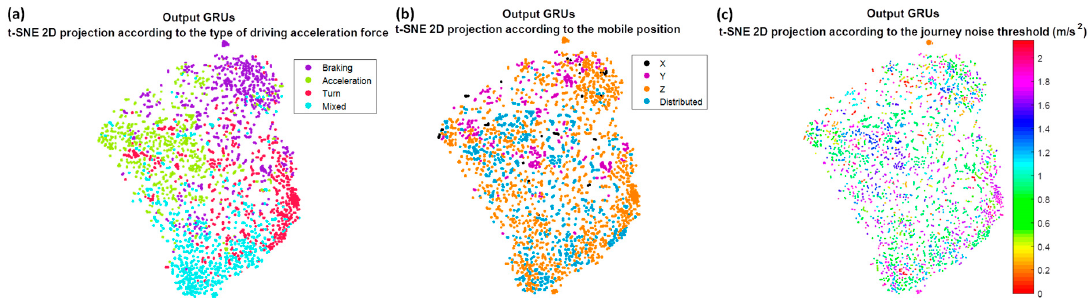
Figure 13. t-SNE 2D projections of feature vectors for raw accelerometers removing gravity input signals to the output of GRU network. ( a ) Projection depends on type of acceleration force. ( b ) According to gravity distribution. ( c ) According to noise threshold of the journey (m/s 2 ).